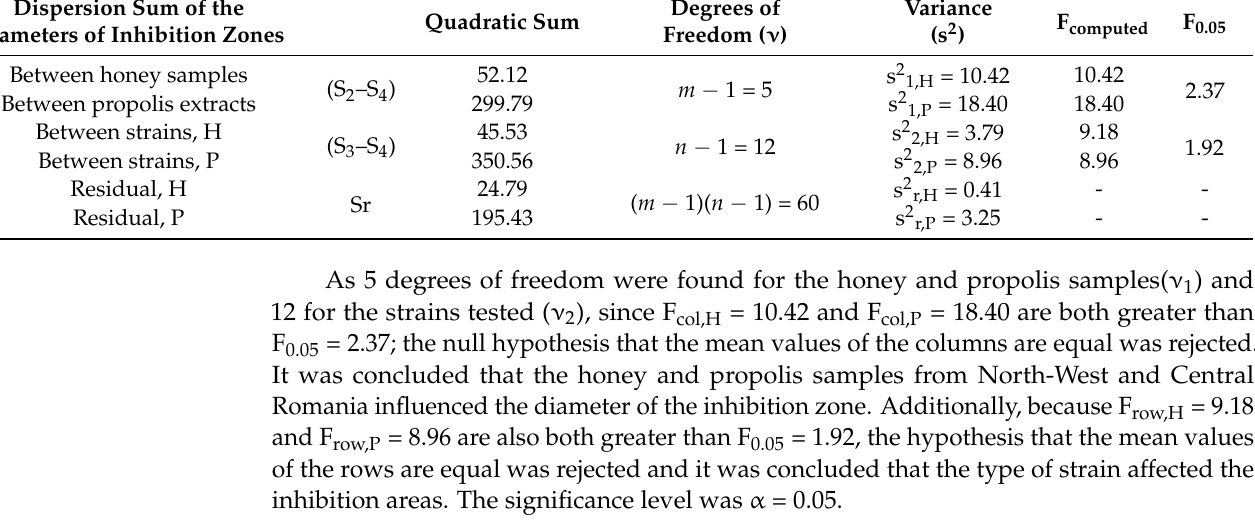
Table 11. Statistical bifactorial analysis of variance for samples from North-West and Central Romania. Dispersion Sum of